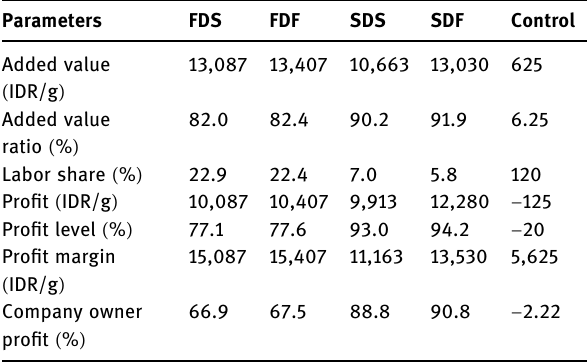
Table 7: The scoring value of parameters observed on each treatment